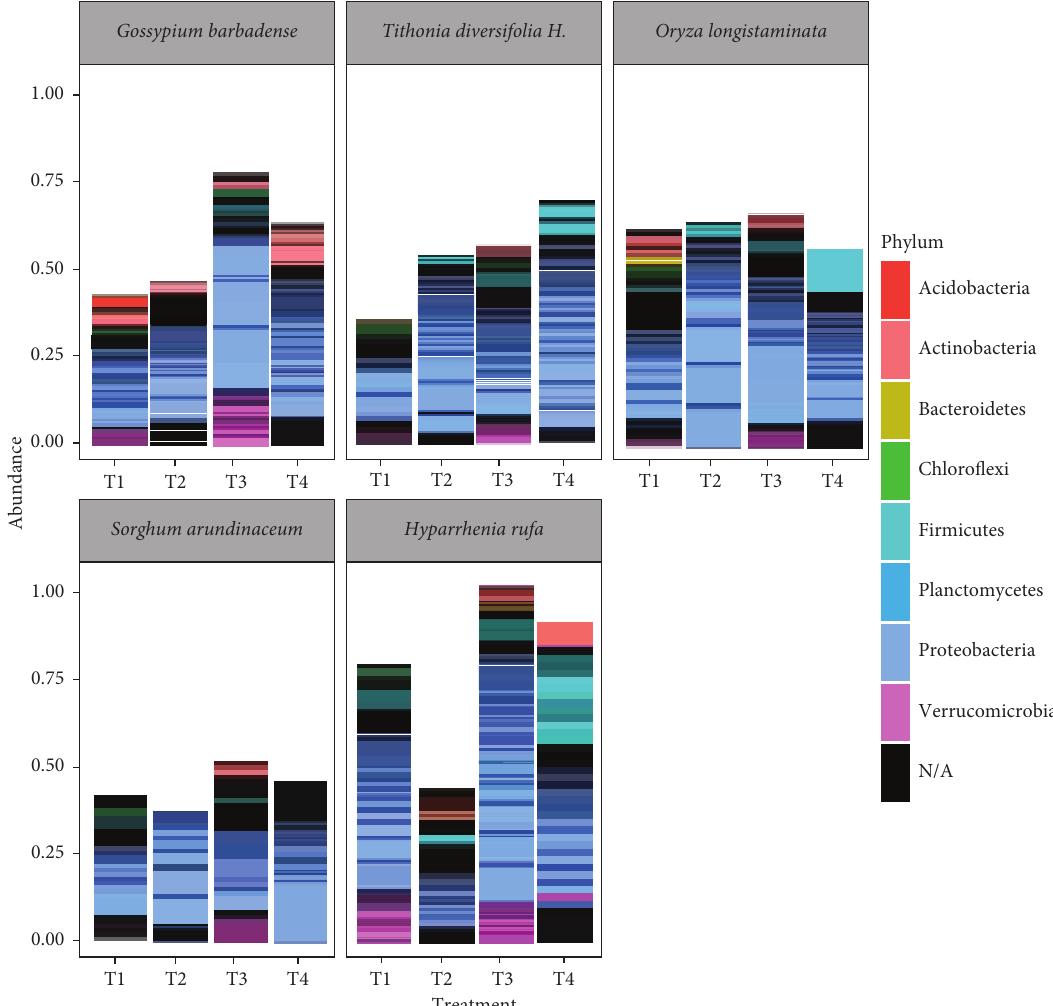
Figure 2: Composition and distribution of bacterial phyla with ≥ 3% relative abundance across five plant spp. with and without compost and petroleum contamination (T1 � plant species only, T2 � plant species and hydrocarbon, T3 � plant species and manure, and T4 � plant species, manure, and